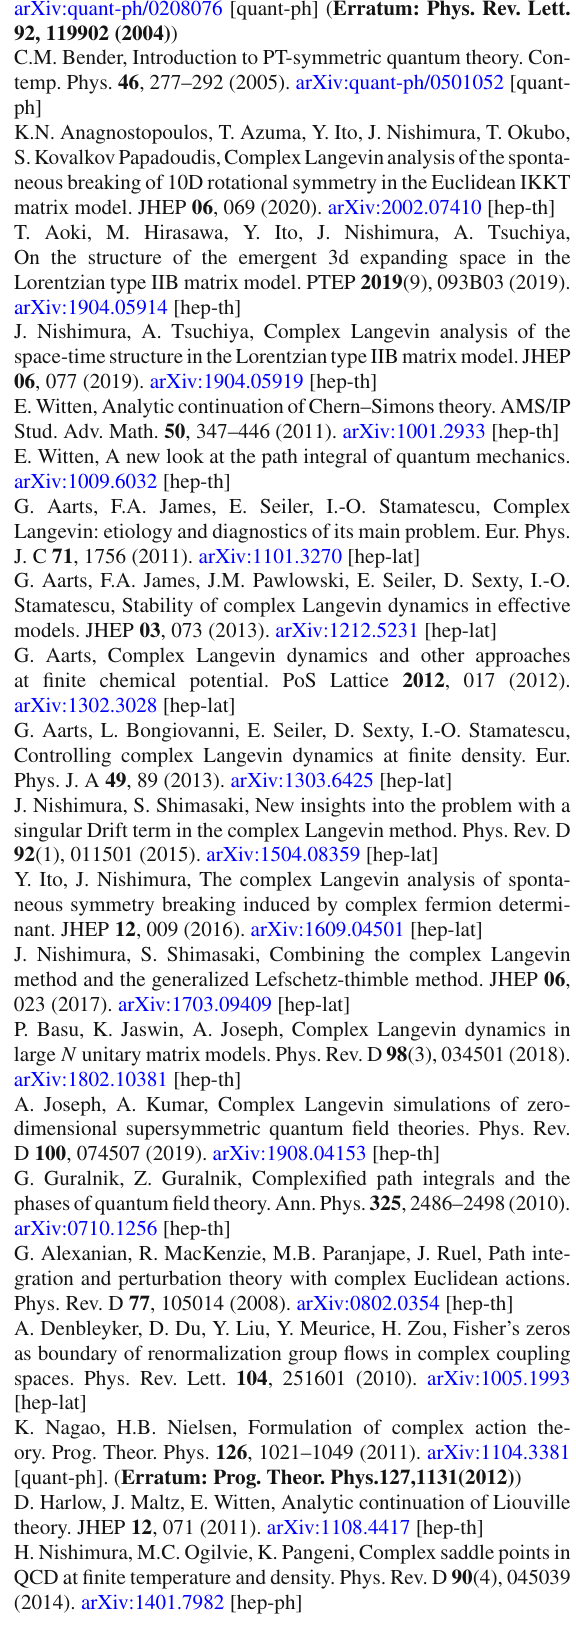
for critical points φ 0 and i